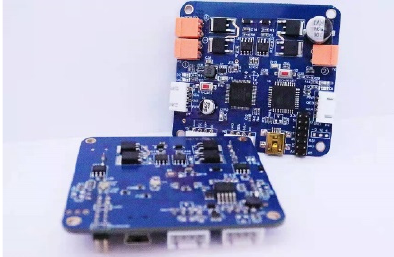
Figure 7. Motor drive board.